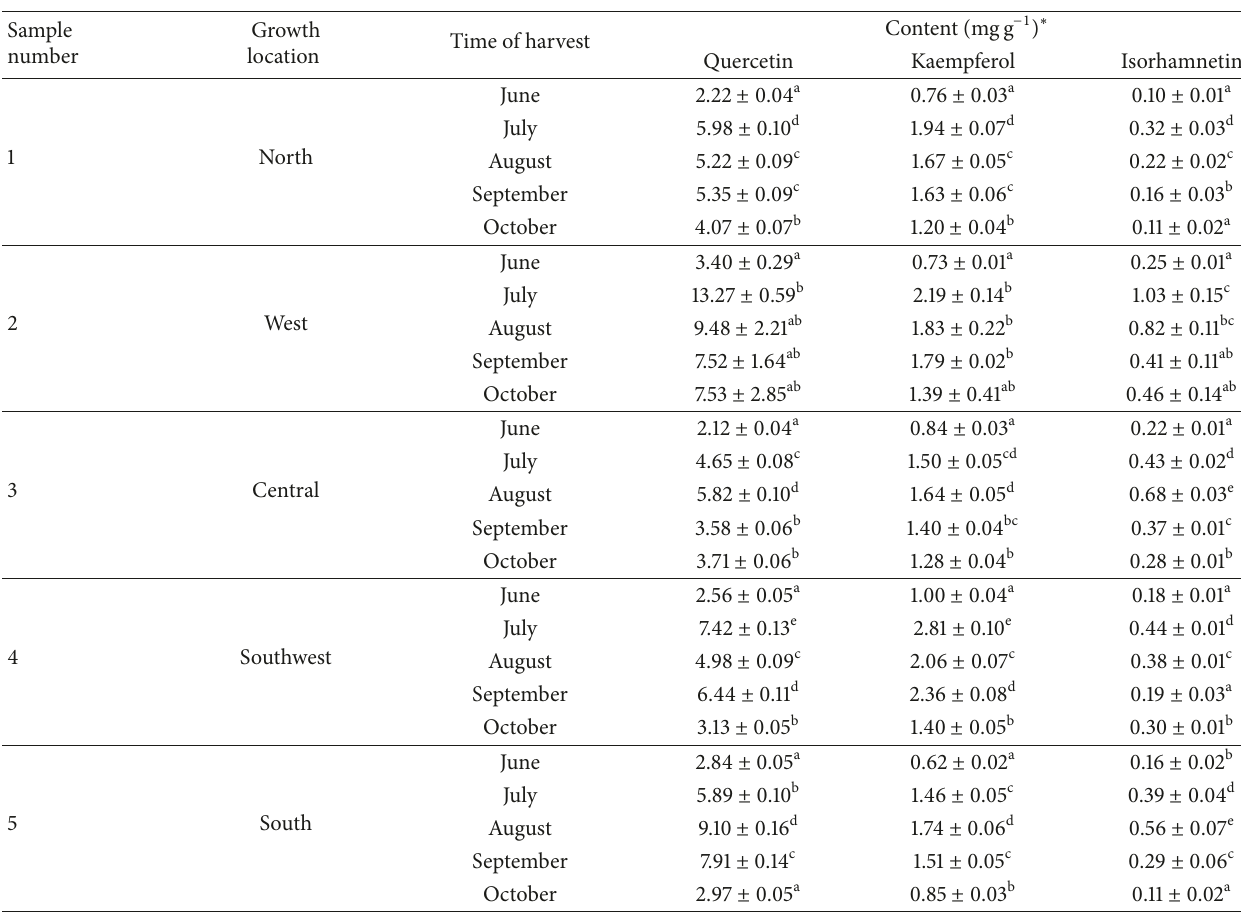
Table 5: Comparison of individual compounds in G. biloba leaf